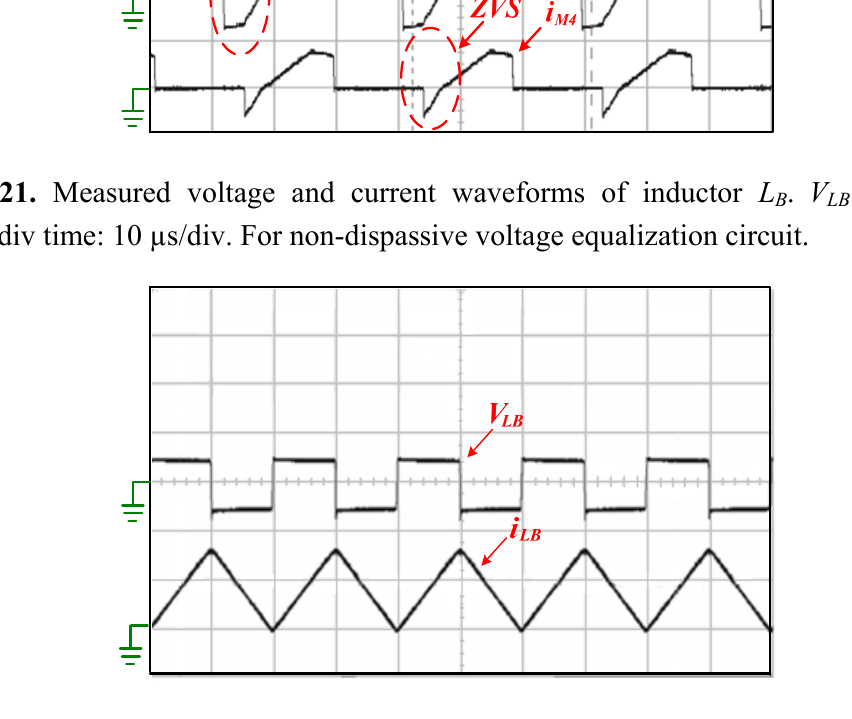
Figure 22. Measured voltage and current waveforms of power switch ( M non-dispassive voltage equalization circuit. V